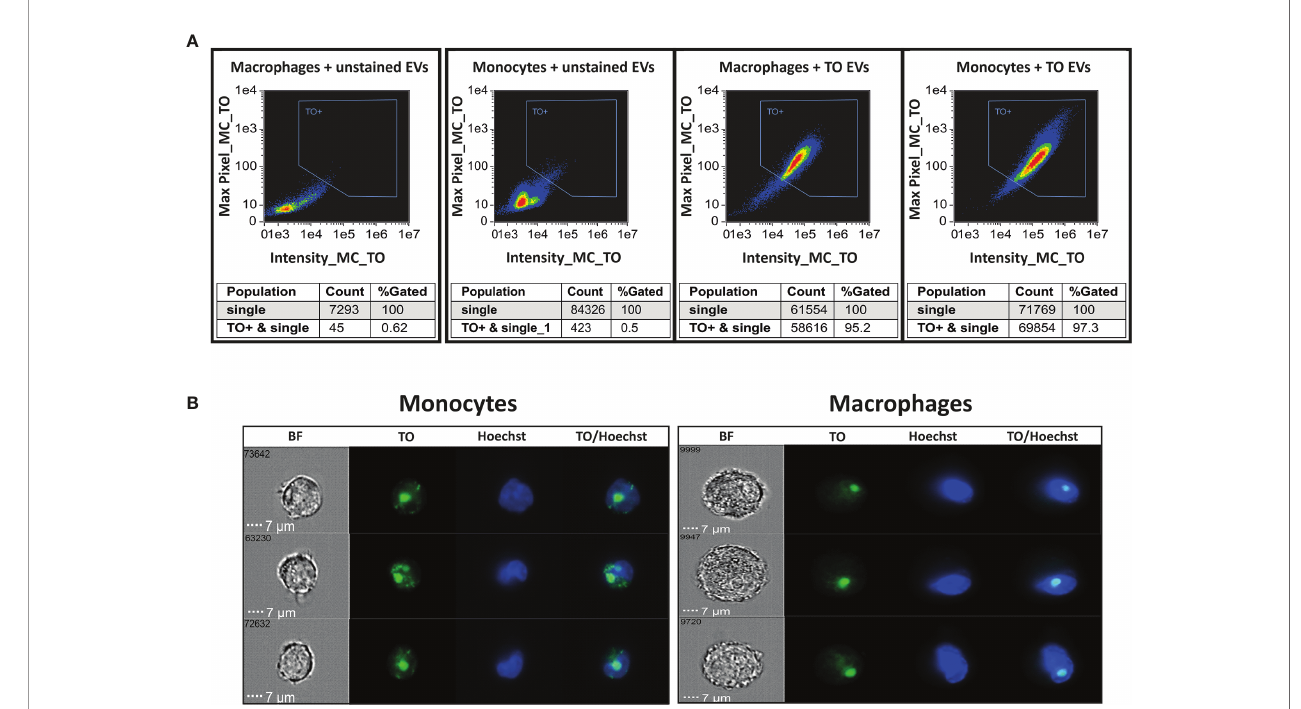
FIGURE 1 | Monitoring uptake of Pf -derived EVs into monocytes and macrophages. Pf -derived EVs were labeled by Thiazole orange (TO) and their uptake into monocytes (THP-1 cells) or macrophages (differentiated from THP-1 cells) was measured for 1 hour. (A) Graphs show the percentage of TO-labeled EV-positive cells after 1 hour, gated according to unlabeled EVs. Tables below the pictures show the percentages of TO positive cells. Representative results from at least three independent experiments are shown. Host cells incubated with unstained EVs were used as controls (left panels). (B) Signal detected by IFC from three individual